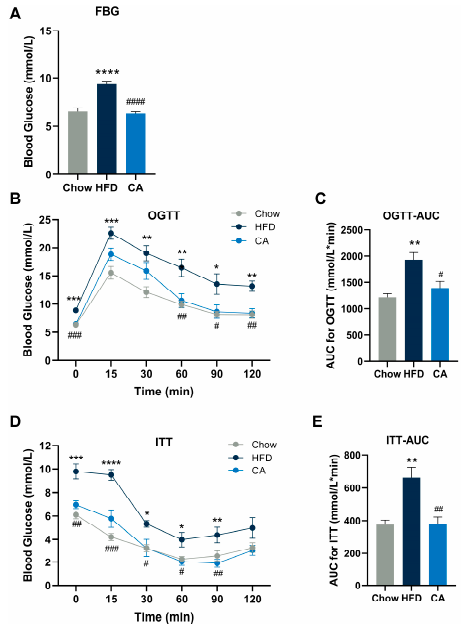
Figure 3. CA improves glucose intolerance and insulin resistance. ( A ) Fasting blood glucose (FBG) level. ( B , C ) Oral glucose tolerance test (OGTT) with its area under the curve (AUC). ( D , E ) Insulin tolerance test (ITT) with its AUC. Data are expressed as means ± SEM ( n = 6). * p < 0.05 vs. Chow group, ** p < 0.01 vs. Chow group, *** p < 0.001 vs. Chow group, **** p < 0.0001 vs. Chow group, # p < 0.05 vs. HFD group, ## p < 0.01 vs. HFD group, ### p < 0.001 vs. HFD group, #### p < 0.0001 vs. HFD group. 3.4. CA Inhibits Hepatic Gluconeogenesis in HFD-Fed Mice PTT was performed, and the HFD group exhibited an increase in gluconeogenesis compared with the Chow group. By contrast, in comparison with the HFD group, CA supplementation significantly inhibited the elevation of blood glucose levels at 30, 60, 90, and 120 min, and the AUC 0–120 min was significantly decreased (Figure 4A,B). Collectively,